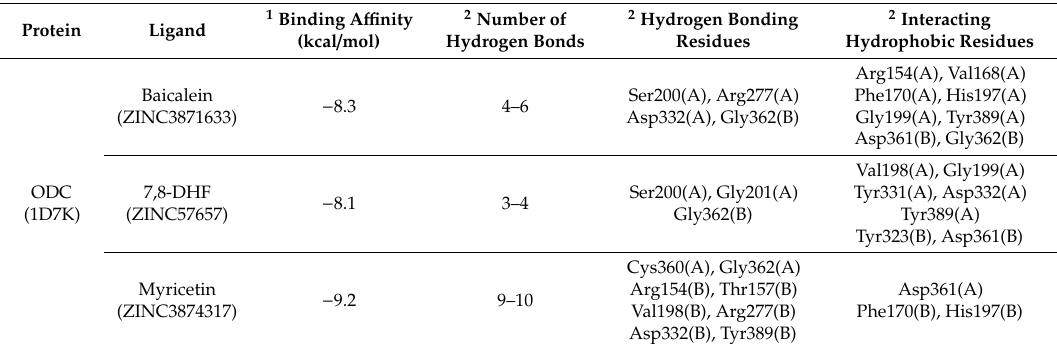
Table 3. Molecular interactions between the ODC dimer and baicalein, 7,8-DHF, and myricetin. Protein